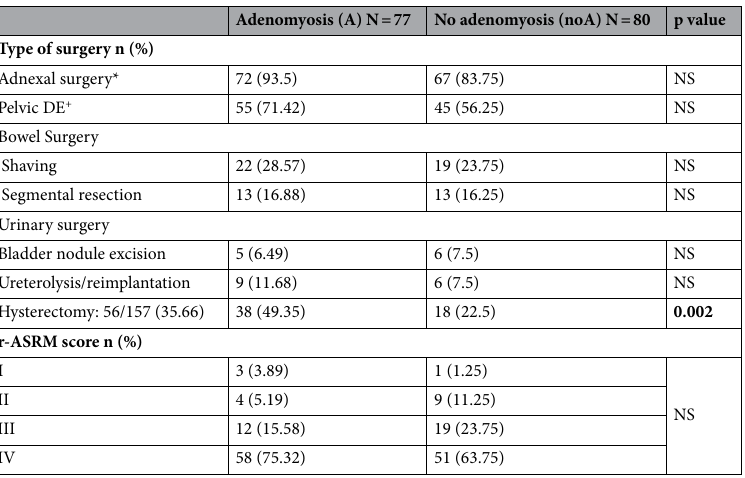
Table 2. Surgical procedures and r-ASRM classification. Significant values are in bold. *Adnexal surgery: unilateral or bilateral including ovarian endometriomas, salpingectomy, adnexectomy. + Pelvic DE: including vagina, uterosacral ligaments, torus uterinus. Data are given as n or %. r-ASRM score revised-American Society of Reproductive Medicine, SD standard deviation, n number, % percentage, NS non-significant.